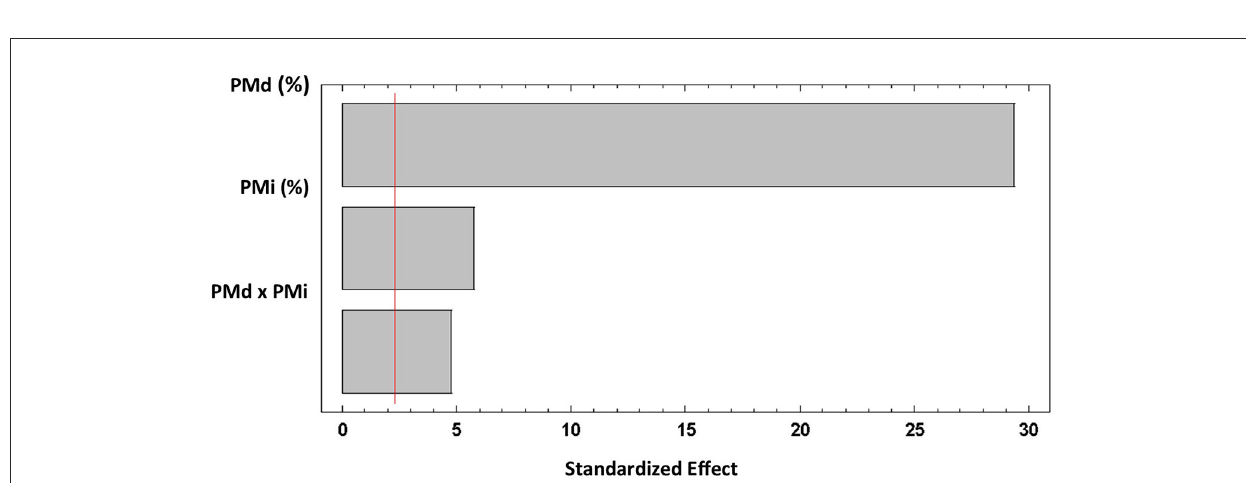
FIGURE3 Pareto diagram shows the effect of the percentage of M. indica and M. dubia pulp on the total phenolic content of ice cream. PMd, M. dudia pulp; PMi, M. indica pulp.